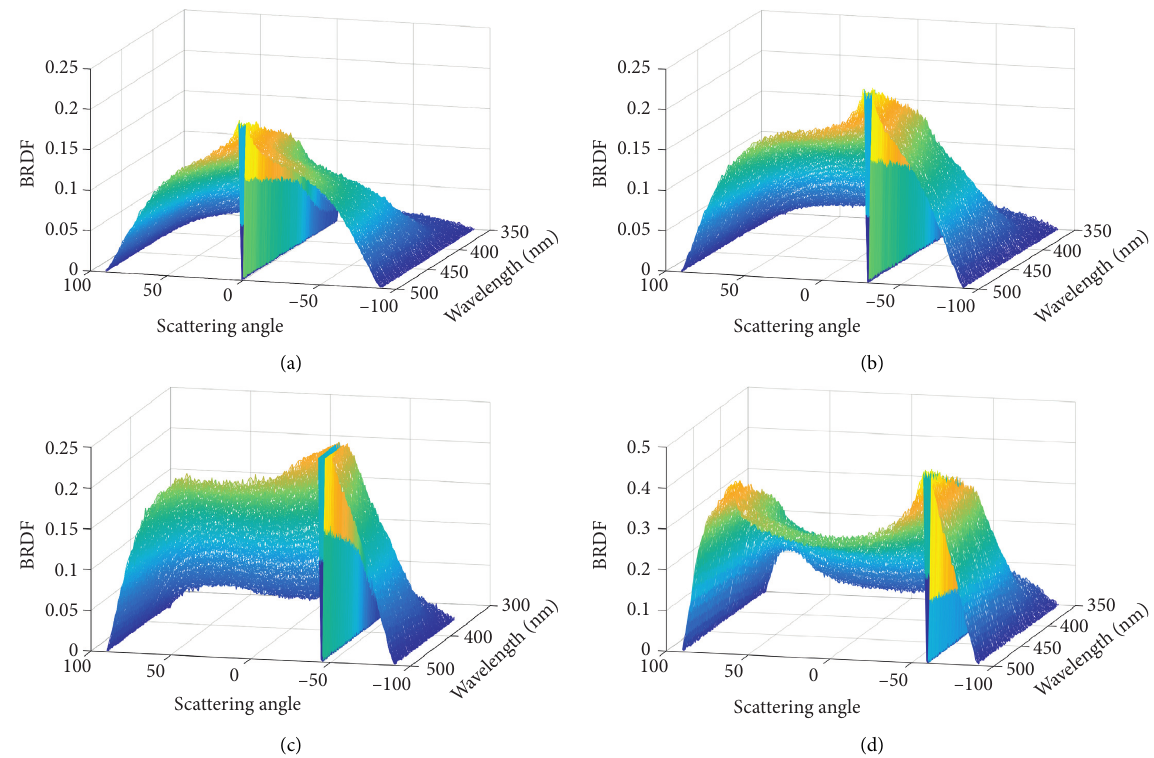
Figure 1: 3D graph of Martian soil BRDF. (a) 3D data of 0 ° incident angle; (b) 3D data of 30 ° incident angle; (c) 3D data of 45 ° incident angle; (d) original data at 60 ° incident